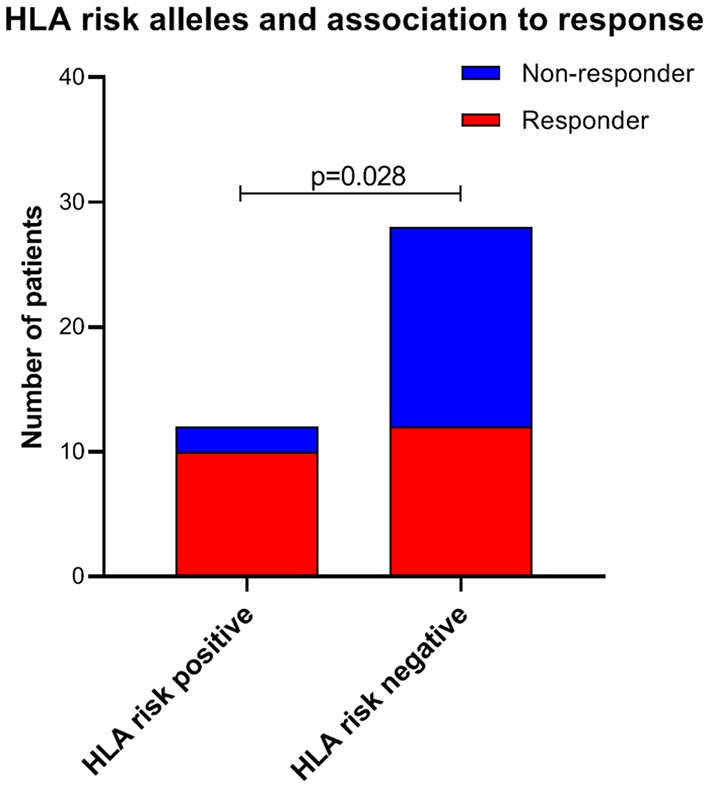
Frequency of HLA risk alleles (HLA DQB1*03:03 and/or HLA C*07:04) in responders and non-responders during follow-up. P-value from Fischer's exact test. HLA, Human Leukocyte Antigen.